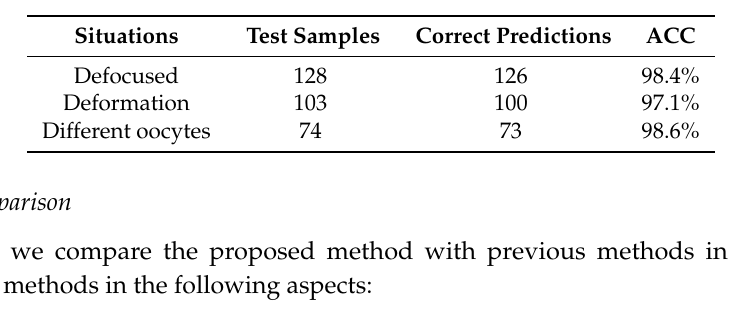
Table 2. Test accuracy of three typical situations.